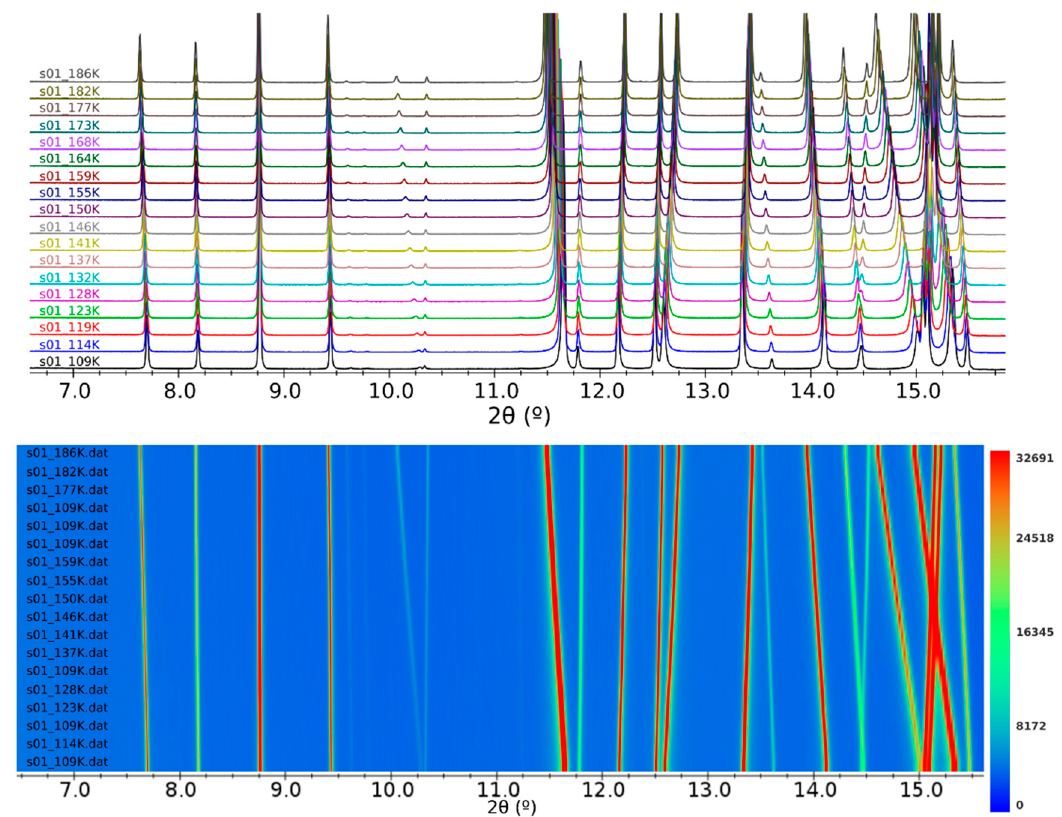
Figure 3. The two plot options for multiple patterns: sequential Y-offset ( top ) and 2D heatmap ( bottom ). XRD data of 1-ethyl-2,3-dimethylimidazolium bromide at different temperatures with peak displacement due to the thermal expansion